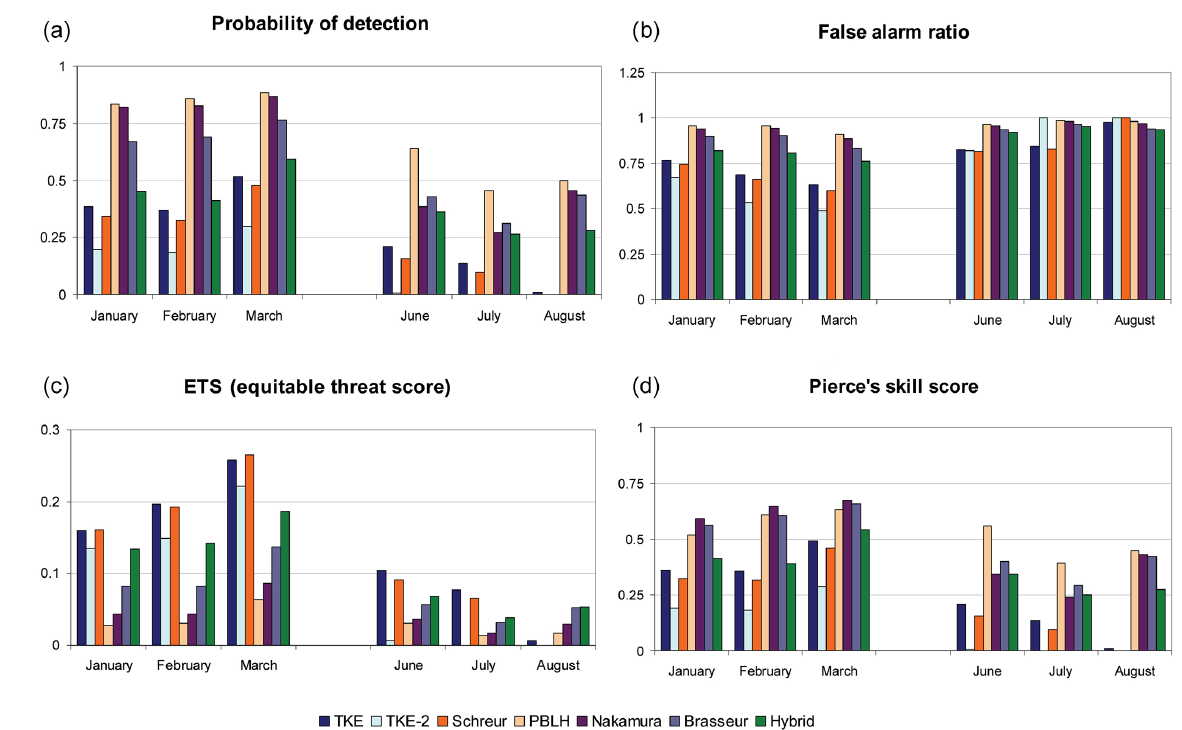
Figure 4. Estimations of wind gust over 15ms − 1 using seven different methods for three winter and three summer months over the European part of